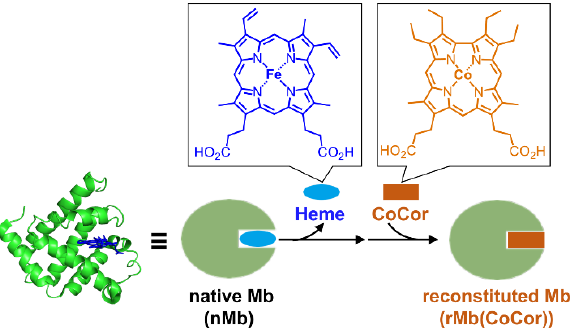
Figure 1. Schematic representation of reconstitution of myoglobin with a cobalt corrole complex.